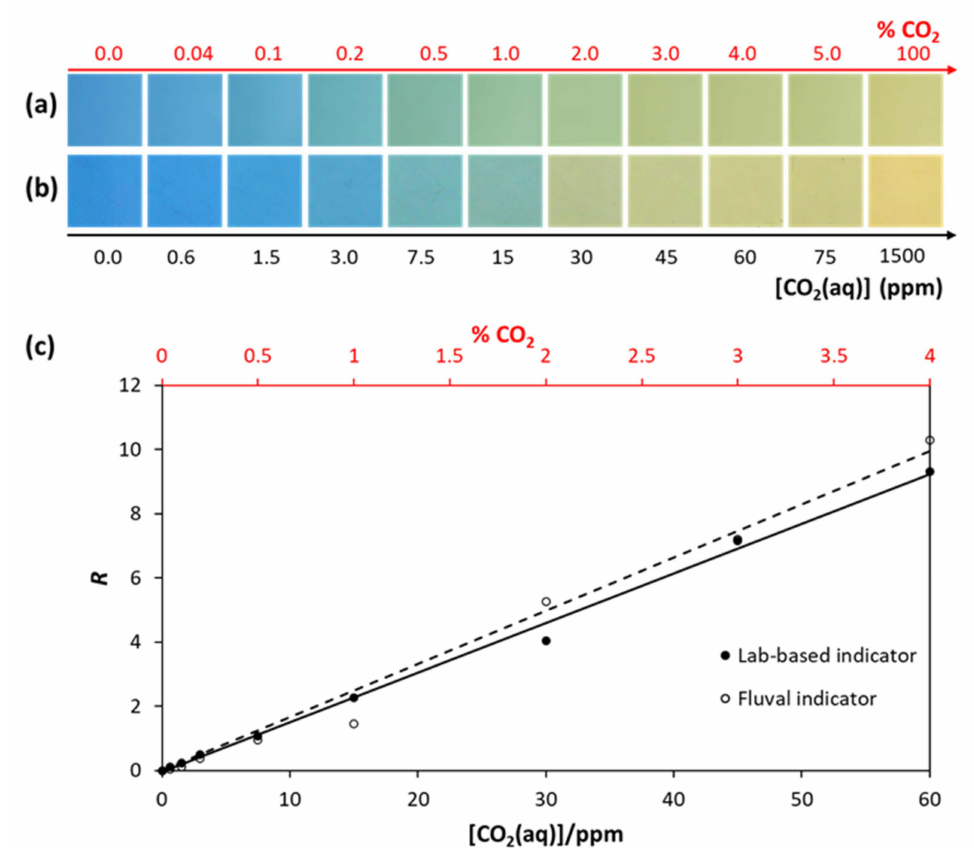
Figure 3. Photographs of ( a ) the lab-based drop check indicator and ( b ) Fluval indicator solutions when sparged with different CO 2 /Ar gas mixtures. The plots in ( c ) are of R vs. [CO 2 (aq)], where the values of R were calculated using Equation (8) and the apparent absorbance values determined from the digital images in ( a ) and ( b ). The solid and broken lines are those of best fit to the data for the lab-based drop check (black dots) and Fluval (open circles) indicators,